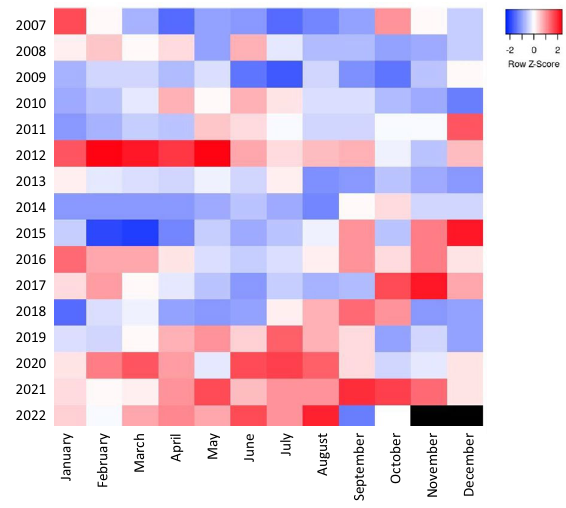
Figure 11. Monthly temperature anomalies calculated from 2007 to 2022 (USGS Orient Harbor Station 01,304,200). Warmer anomalies are presented in red while colder anomalies are in blue. The recurrent scallop outbreaks were first noted in summer 2019, and are systematically associated with warmer spring/summer